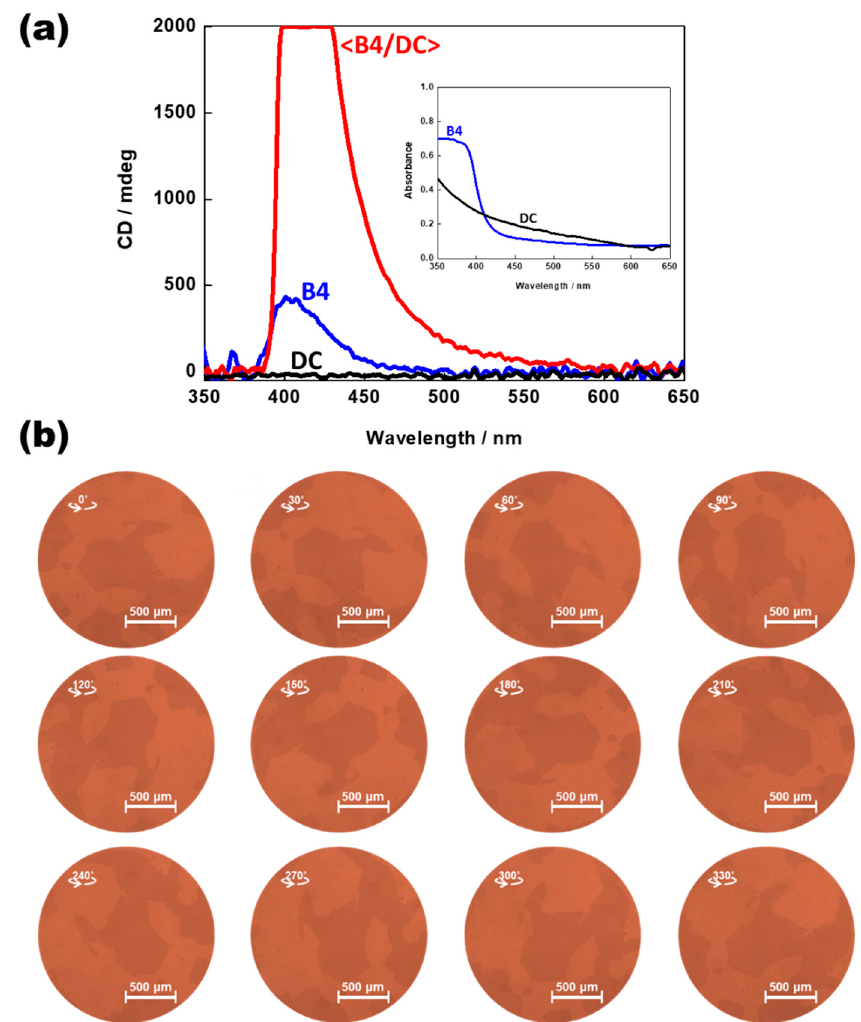
Figure 6. ( a ) Typical induced CD spectra of pure HNF B4 (BC molecule), pure DC (BCMP), and <B4/DC> (binary mixture) (inset: absorbance spectra of pure HNF B4 (BC molecule) and pure DC (BCMP)). ( b ) POM images of <B4/DC> taken by rotating the cell about cell surface normal under uncrossing conditions.